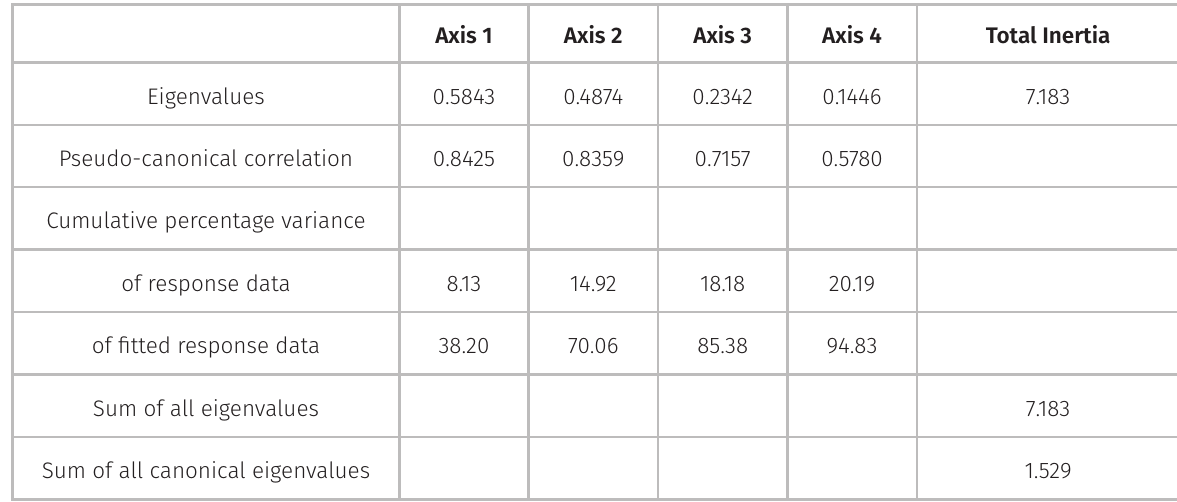
Table Va. Summary statistics for CCA analysis.